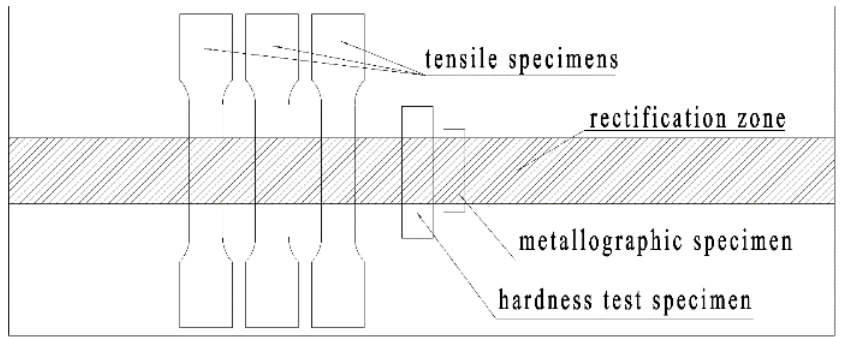
Figure 3. Shape of tensile specimen (mm).